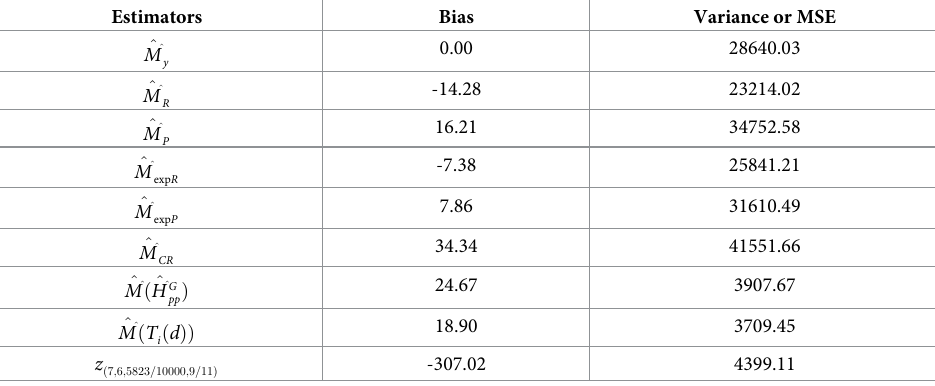
Table 3. Bias and MSE values of members of the proposed class of estimators for population 2.